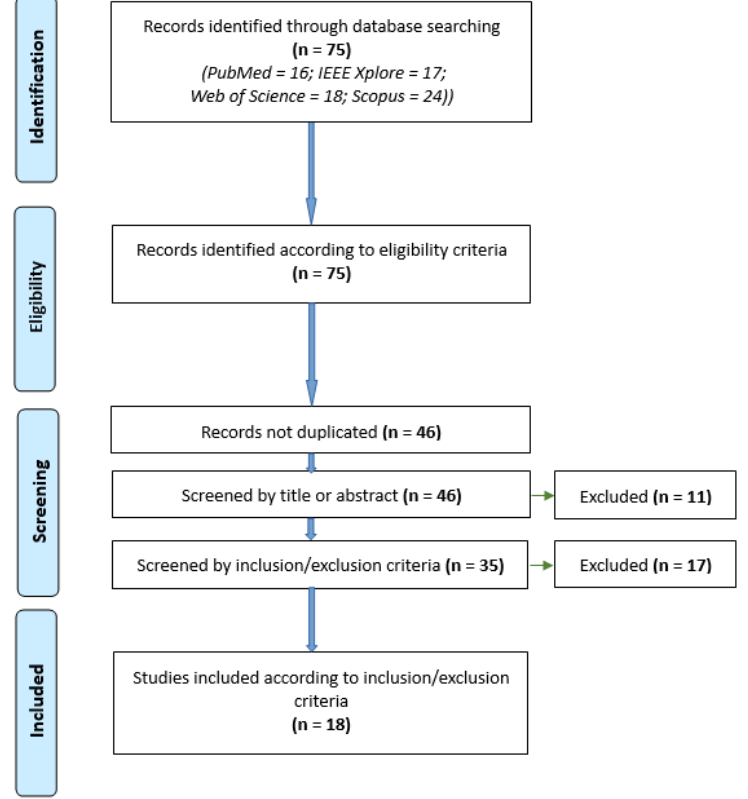
Figure 1. Chart for identifying relevant studies.